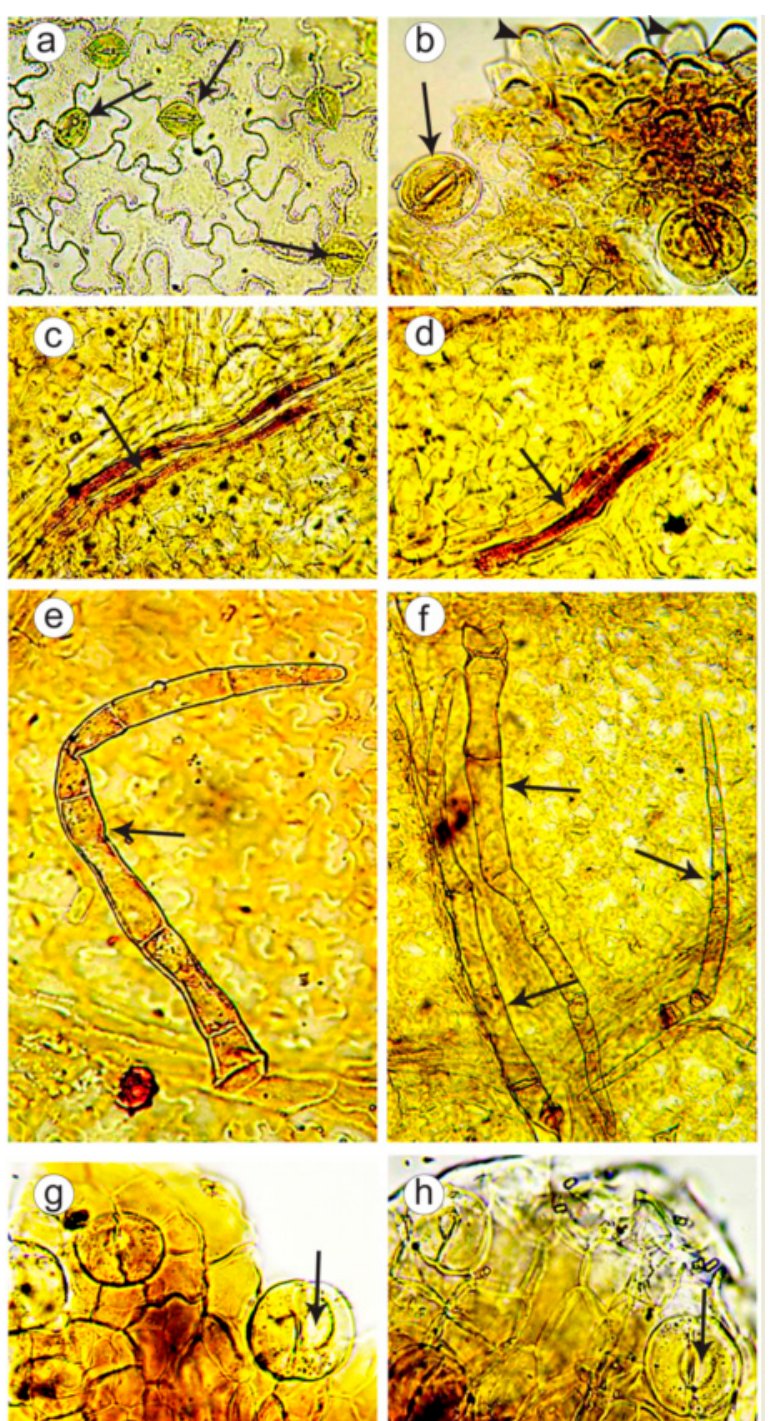
Figure 3. Micro-morphology of the epidermis of leaves and flowers in plants of the control normal-flowered (K 171-1) and double-flowered (K 211) populations of Chelidonium majus . Cells of the lower epidermis of a leaf: ( a ) K 211, cell with stomata (arrows) (magnification × 200), ( b ) K 171-1, cell with stomata (arrows) and crenate teeth with nipple-shaped cells (arrow heads) ( × 400). Lactiferous cells (arrows) observed along a leaf vein ( × 400): ( c ) K 211, ( d ) K 171-1. Simple long pluricellular hairs (arrows) on the leaf epidermis: ( e ) K 211, ( f ) K 171-1 ( × 200). Top of a sepal with water stomata (arrows) (x400): ( g ) К 211, ( h ) K 171-1.